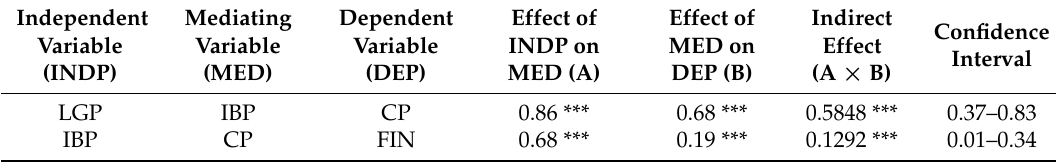
Table 6. Mediating Analysis Based on 2000 Bootstrap